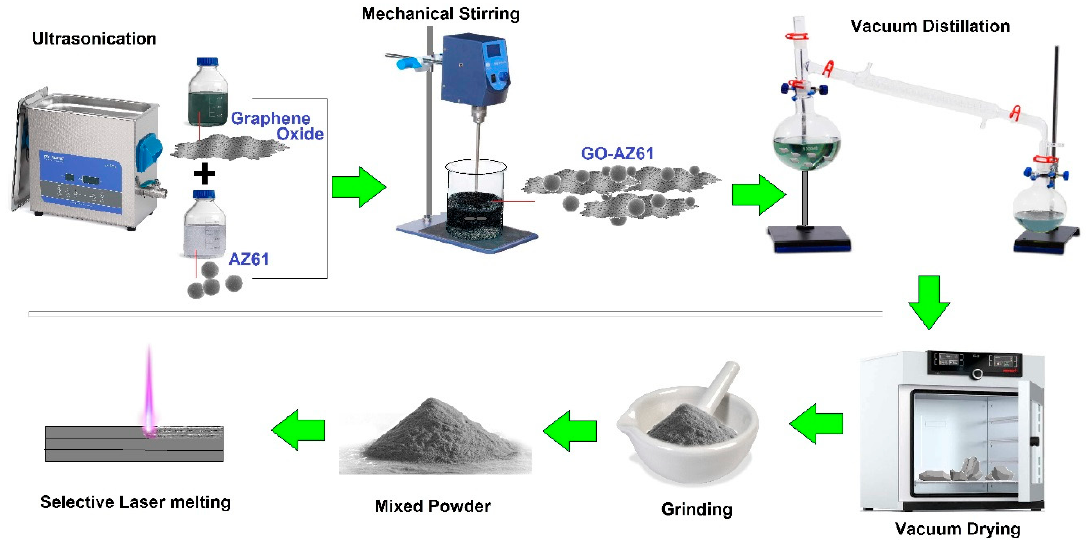
Figure 9. Schematic diagram for the preparation of GO reinforced AZ61 magnesium alloy by selective laser melting (SLM) reproduced from [102], with permission from Elsevier, 2019.